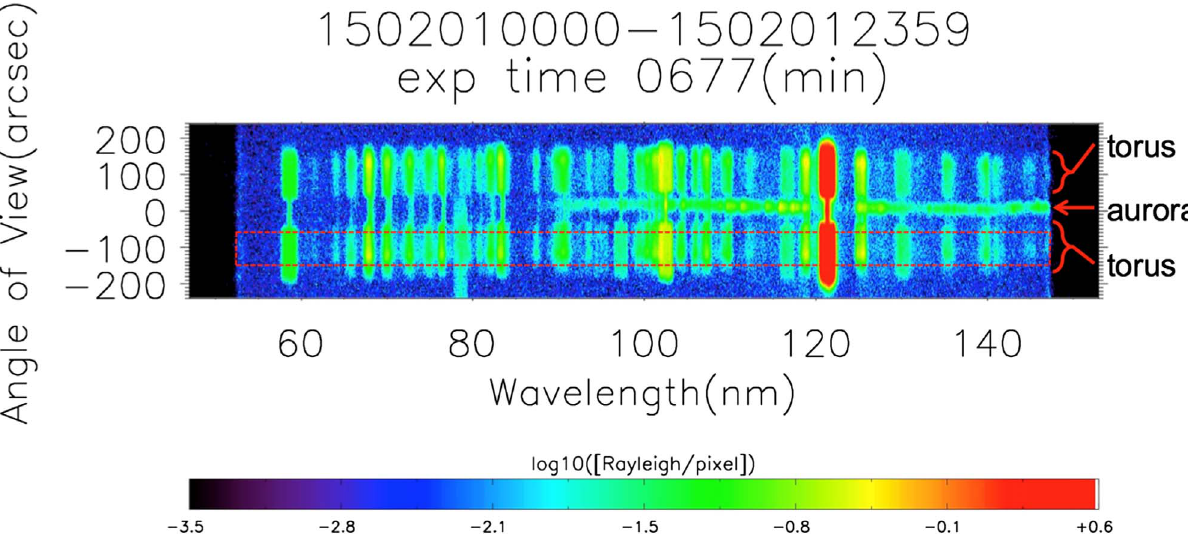
Fig. 7. Integrated imaging spectrum of EUV-L2 observed on 1 February, 2015. Horizontal and vertical axes show wavelength (nm) and arrival direction (arcsec) of photon events, respectively. Color shows the brightness in Rayleigh/pixel in logarithmic scale. This fi gure plots the region of 1024 (wavelength axis) (cid:3) 117 (spatial axis) pixels on the detector for good visibility. Observation targets were Jupiter ’ s aurora and the Io plasma torus. Spatial regions corresponding to the aurora and torus are annotated by the red arrow and curly brackets, respectively. Integration time is 677 min i.e., 677 image extensions of EUV-L2, corresponding to a 1-day observation time. Brightness in the region framed with the red broken line is reduced to the one-dimensional spectrum in Figure 11 by spatial integration. The framed region corresponds to a planeto-centric distance of 3 – 7 Jovian radii from Jupiter.